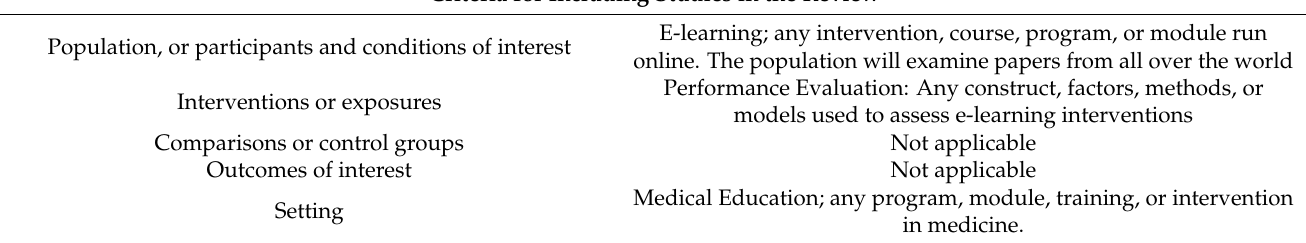
Table 1. Inclusion